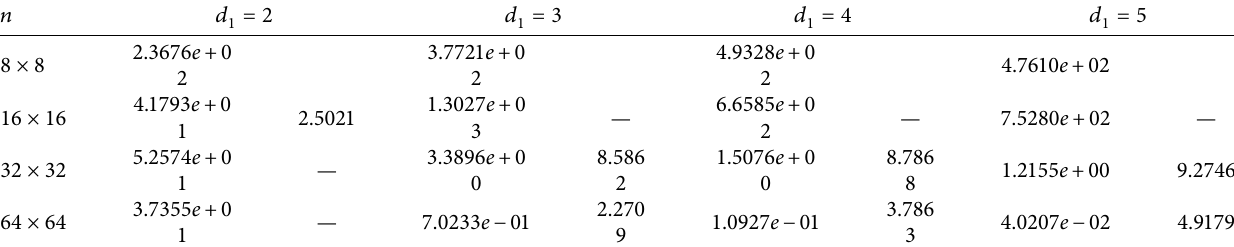
Table 6: Convergence rate of bending moment with equidistant nodes d